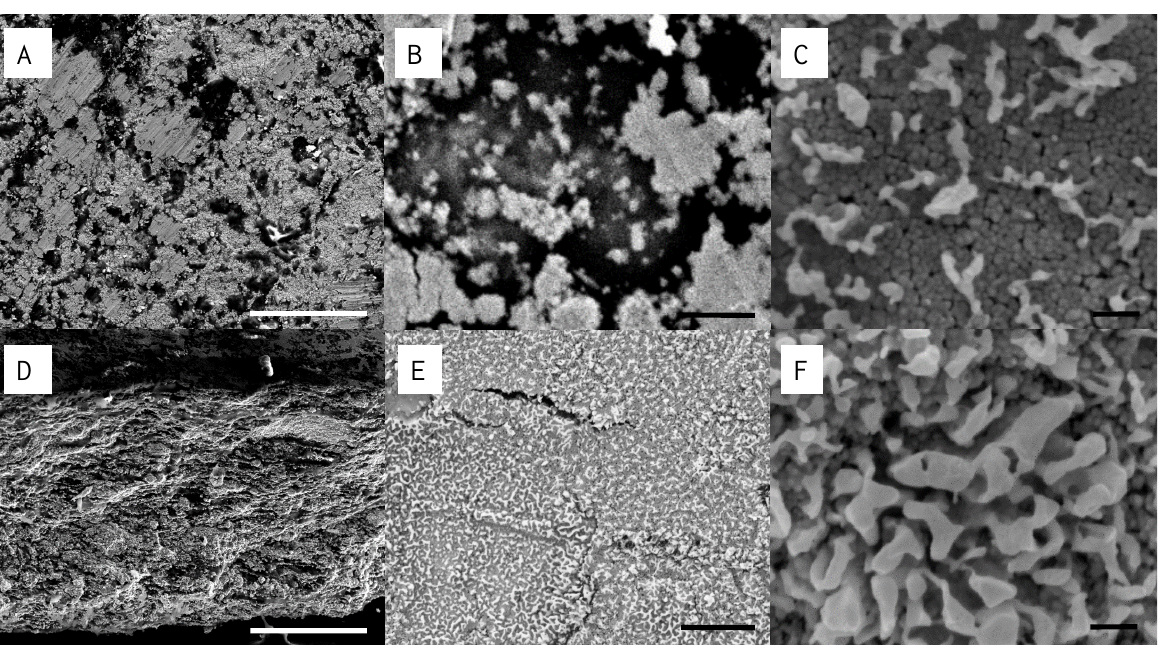
Figure 2. Representative SEMs of the silica - silver cold-pressed composites at 20 ton·m −2 ; ( A – C ) are surface and ( D – F ) cross section images of a 10 wt% silica content composite. The scale bars of ( A , D ), ( B , E ) and ( C , F ) respectively represent 100 μm, 1 μm and 100